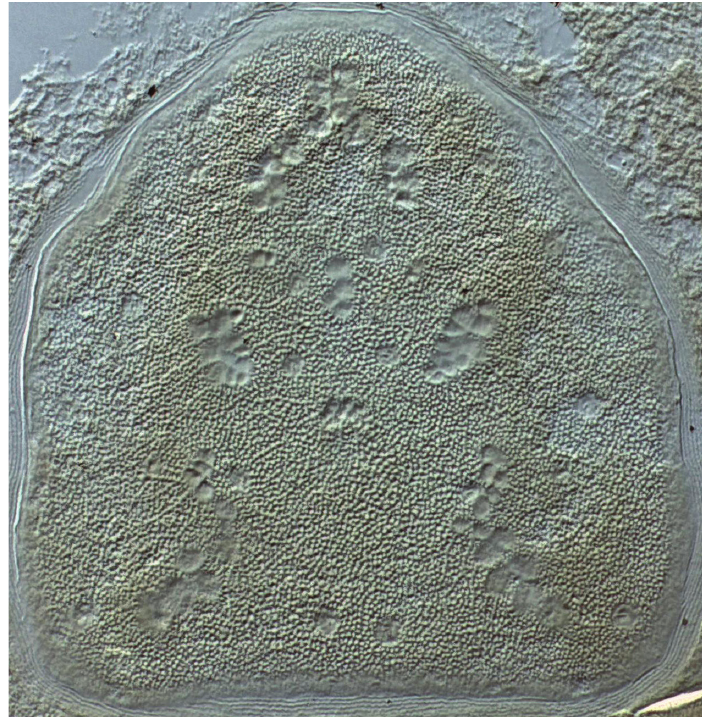
Figure 2. Female Sternostoma gallowayi sp. n. podosomal shield. type. Two females (CNC991941, CNC991942) from horned lark (WK625), Win- nipeg, Manitoba, Canada, 5.viii.2014, coll. TD Galloway. Diagnosis female. Dorsum with two shields, podosomal shield large, covering most of podosoma with eight pairs of minute setae and two pairs of pore-like struc- tures, opisthosomal shield medium-sized with two pairs of minute setae and four pairs of pore-like structures. Two pairs of minute setae in dorsal opisthosomal unsclerotised integument. Paranal setae on anal shield level with anus, postanal seta absent. Sternal shield longer than wide, three pairs of sternal setae ( st1 – 3 ) on shield. Genital shield slightly reticulated lengthwise, broadly rounded posteriorly, seta st5 on genital shield. Four pairs of minute setae in ventral opisthosomal unsclerotised integument. Ventral subcapitulum without setae. Ventrolateral and apical setae on tarsus II–IV thickened, baculiform and slightly curved